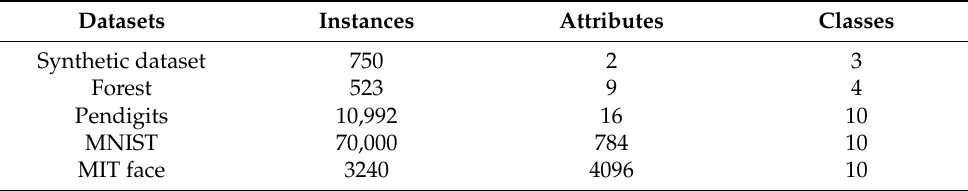
Table 1. The description of five datasets. Datasets Instances Attributes